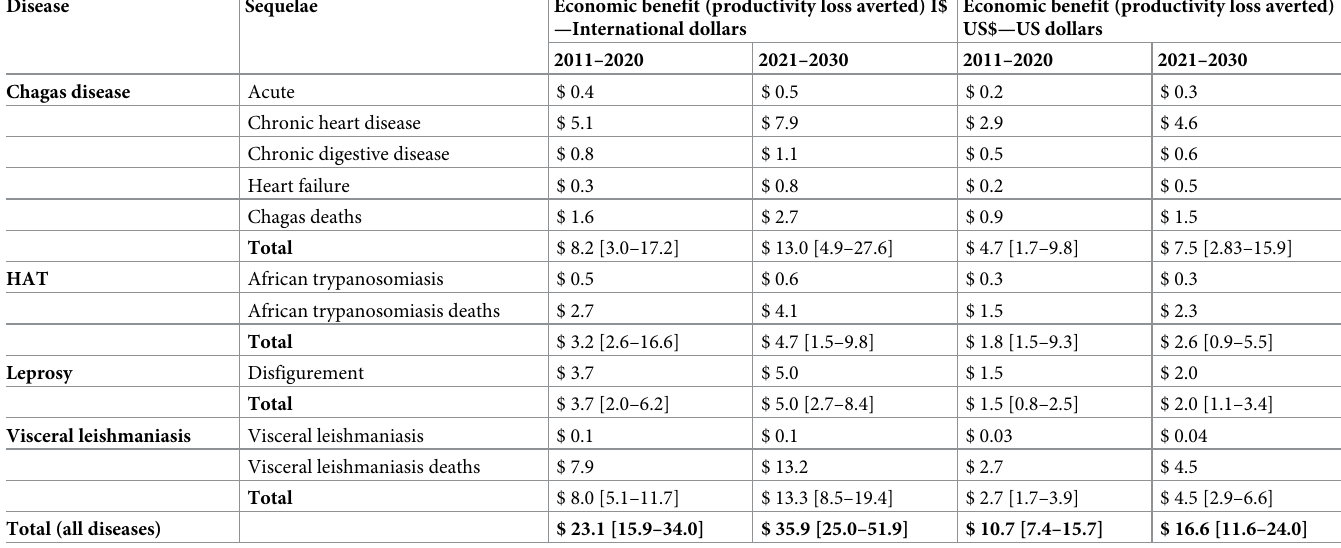
Table 6. Total economic benefit from productivity loss averted, base case estimates and 2.5 th and 97.5 th percentiles (billions I$—International dollars and US$—US dollars 3% discounting from 2010).